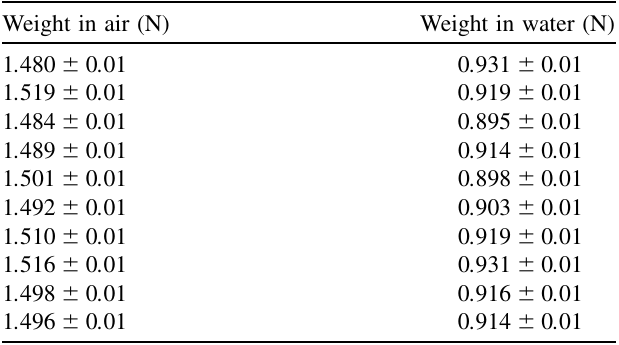
TABLE VIII. Results of several measurements of cube’s weight in air and in water.